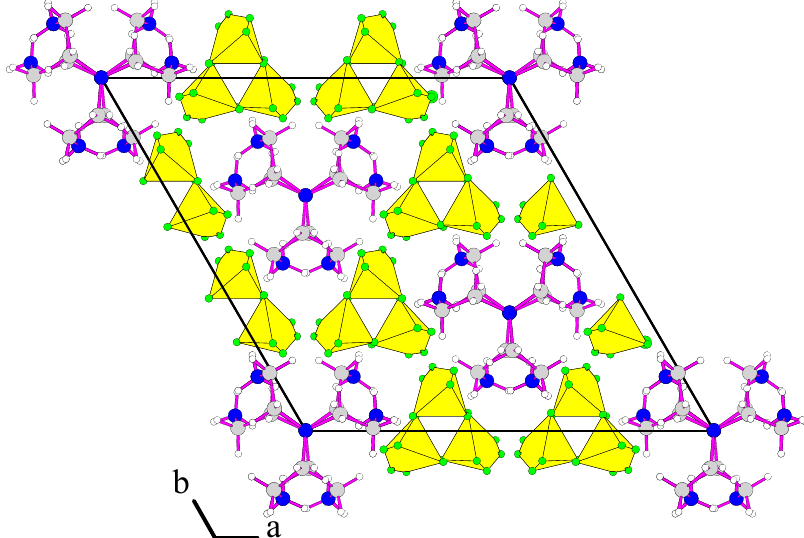
Figure 4. Projection of the structure of [H 3 tren ](BF 4 ) 3 HF along the [001] direction.